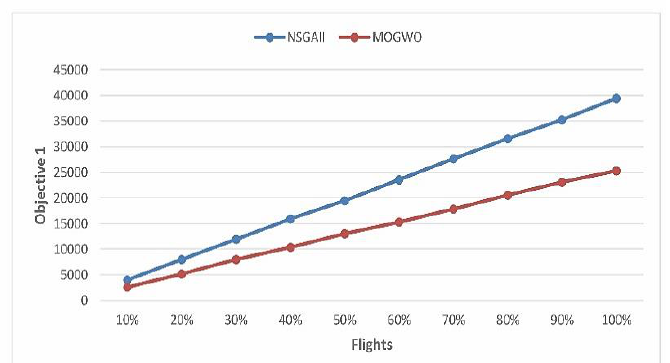
Fig. 2. Comparison of MOGWO and NSGAII methods on the first-objective